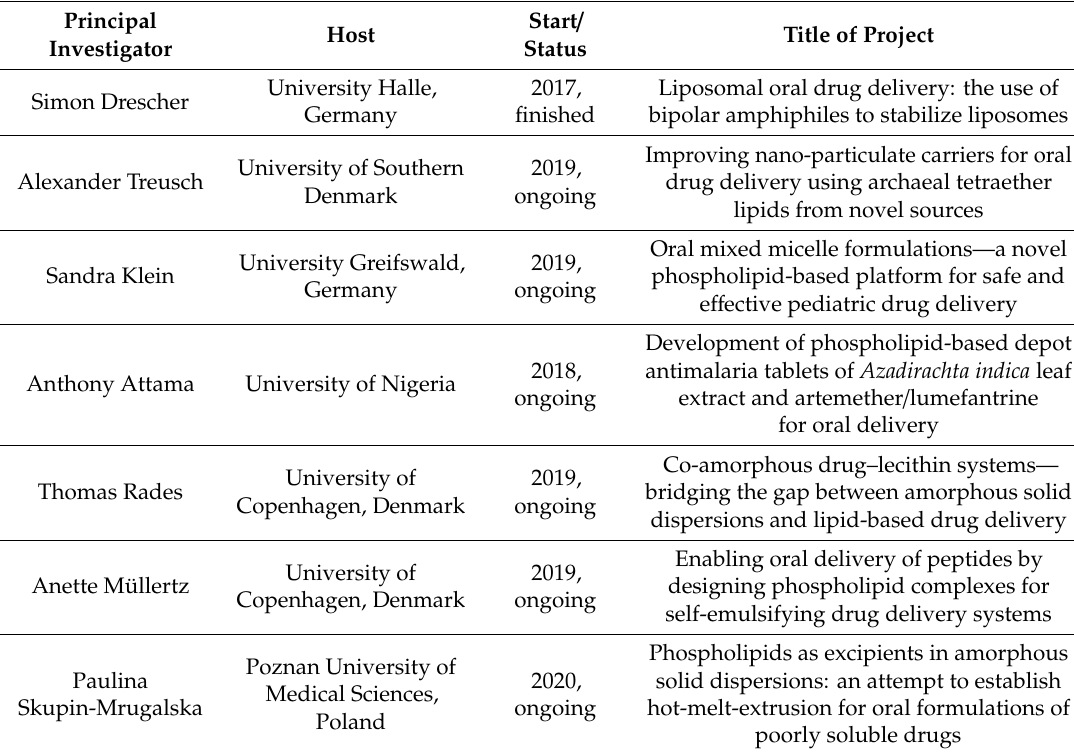
Overview of PRC-funded research projects (2017–now) covering the oral use of lipid-based